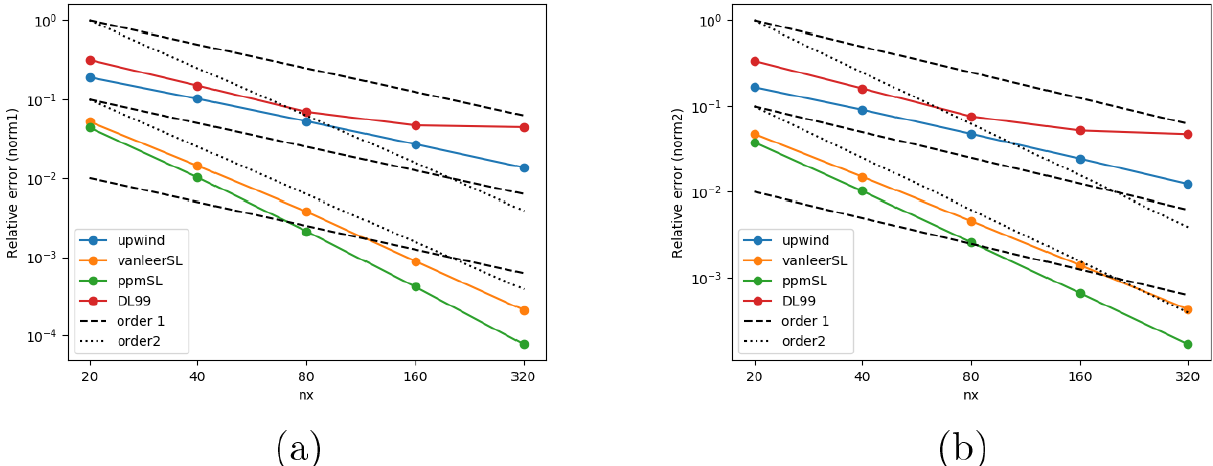
Figure A1. Convergence rate results for the four tested vertical advection schemes as a function of the number of horizontal points n x in the horizontal direction, in (cid:107)·(cid:107) 1 (a) and (cid:107)·(cid:107) 2 (b) for Case 4.